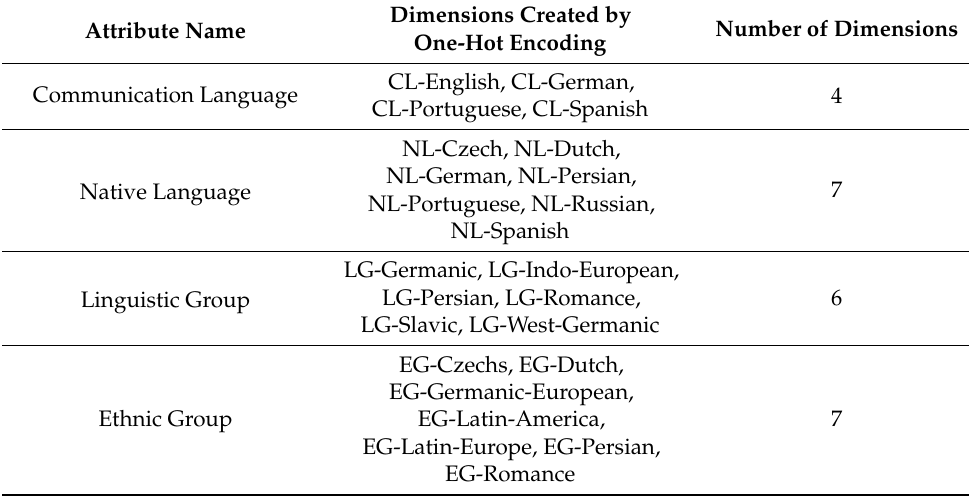
Table 2. Attributes and the dimensions created by one-hot